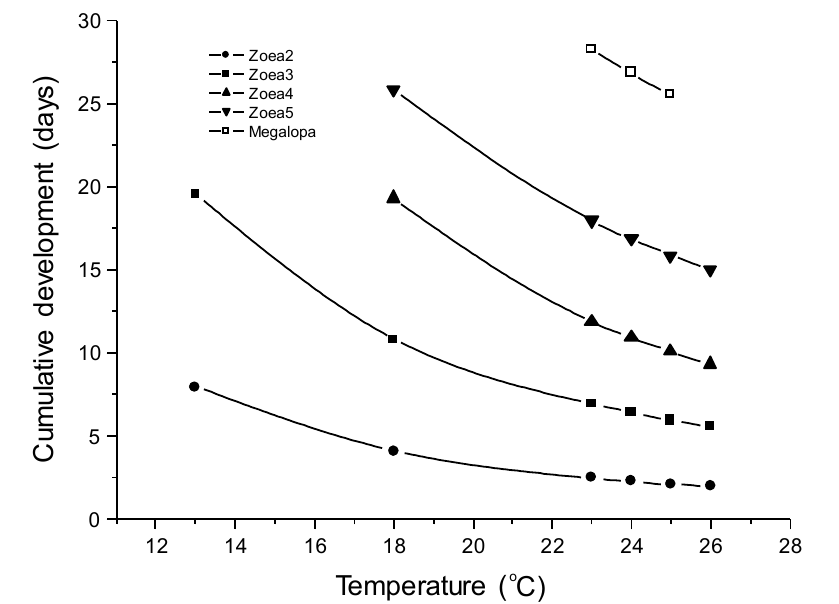
Figure 4. Relationship between temperature and developmental period from hatching to reach each larval stage of D. japonicus . Curves show theoretically calculated values using non-linear regression equations (power functions, y = a × T b ).